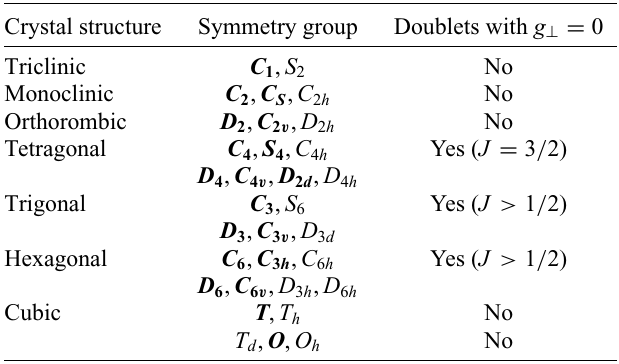
TABLE I. Kramers ions will always have some doublets with nonvanishing g ⊥ (cid:16)= 0, irrespective of the point group. Here we tabulate the possibility that doublets with g ⊥ = 0 also occur in the various crystallographic point groups. Point symmetry groups with Kramers doublets that also allow for electric dipole moments are highlighted in bold.